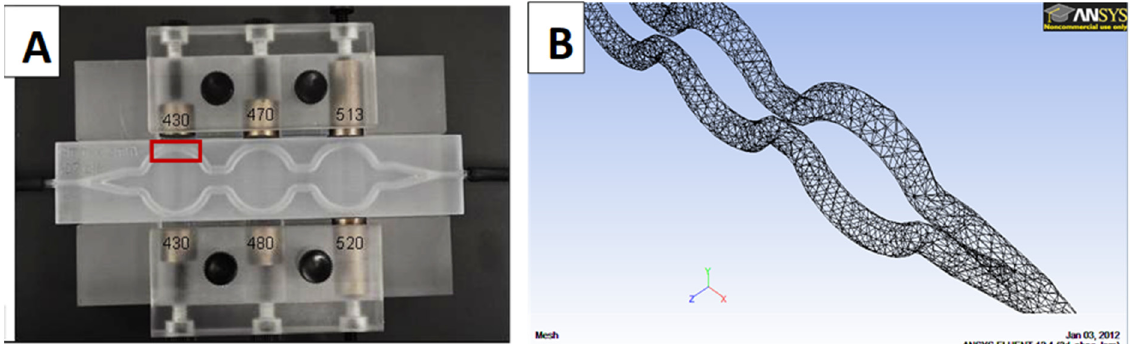
Figure 2. Three-stage magnetic trap. ( A ). Photo of trap showing paired channels with collection curves and collection magnets. Magnets are 10 mm in diameter, and the total internal volume (both channels) is 3.8 mL. Captured cells are collected by flushing the channels after removing the single-use channel assembly from the magnets. Rectangle shows region of interest for magnetic calculations. ( B ). Mesh was applied to the channels of the trap for CFD using FLUENT.